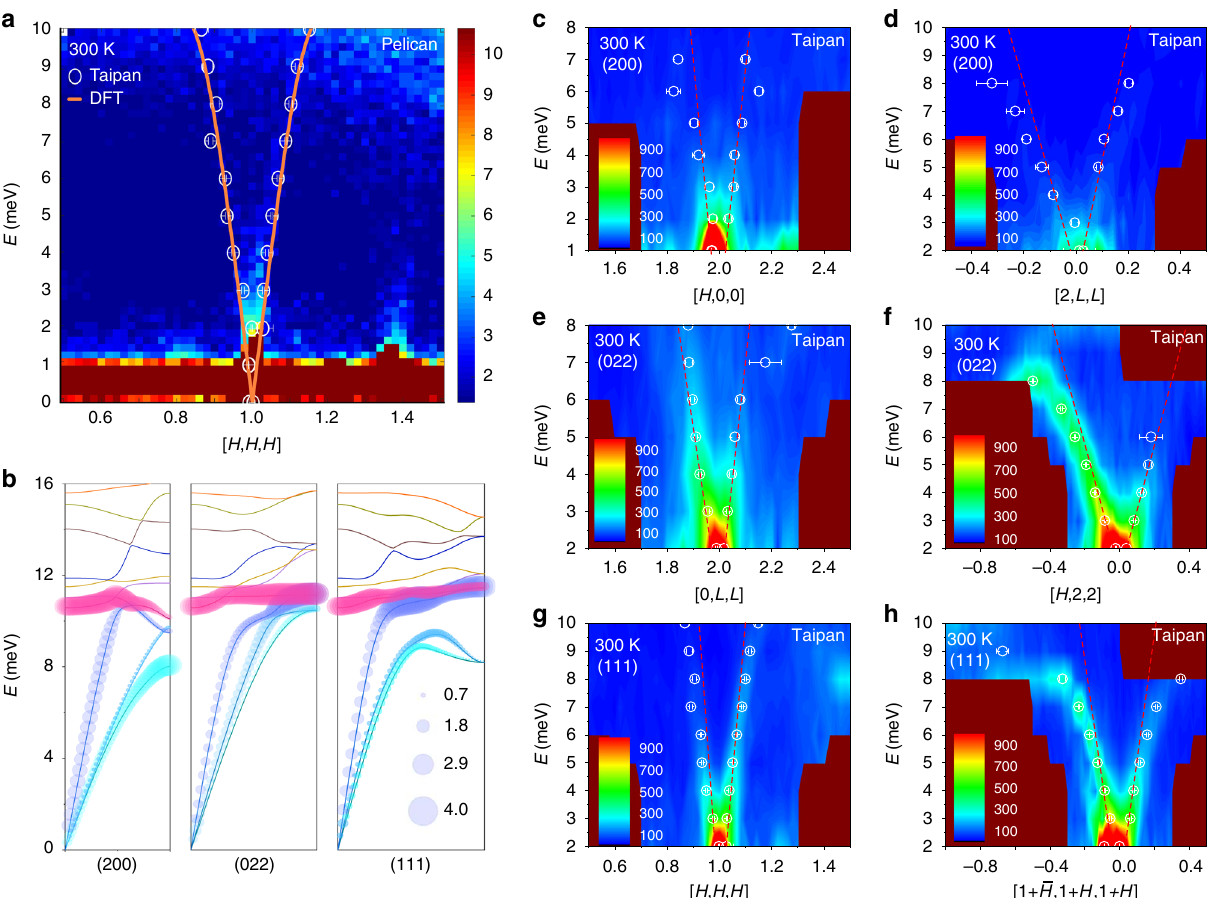
Fig. 3 Phonon dispersions of CuP 2 . a The phonon dispersion obtained at the time-of- fl ight neutron spectrometer-Pelican along [ H , H , H ] direction of Brillouin zone G = (111). The circles are the corresponding results obtained from the triple-axis spectrometer — Taipan. The orange lines are the calculated dispersions. b Calculated phonon dispersions of Brillouin zones G = (200), G = (022), and G = (111). The size of the shadow bubbles represents the magnitude of Grüneisen parameter ( γ ) of the related branches. c – h Phonon dispersions of G = (200), G = (022), and G = (111) Brillouin zones collected at Taipan. The circles are the phonon energies determined by the spectral fi tting to a Lorentzian function. The red dashed lines represent the linear fi tting of phonon branches approaching the Brillouin zone centers to determine the sound